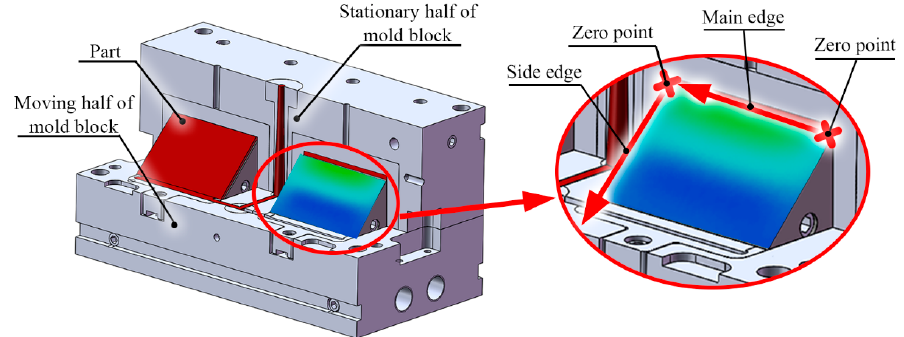
Figure 6. The notations used for the evaluation of the measurements, the side edge near the sprue and the main edge on the top of the moving insert. the main edge on the top of the moving insert.